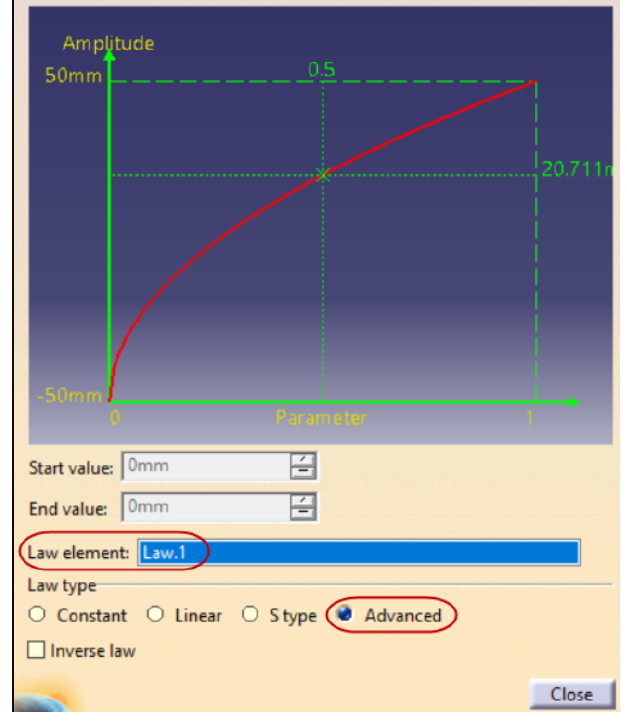
Fig. 9 Geometric curve design interface and